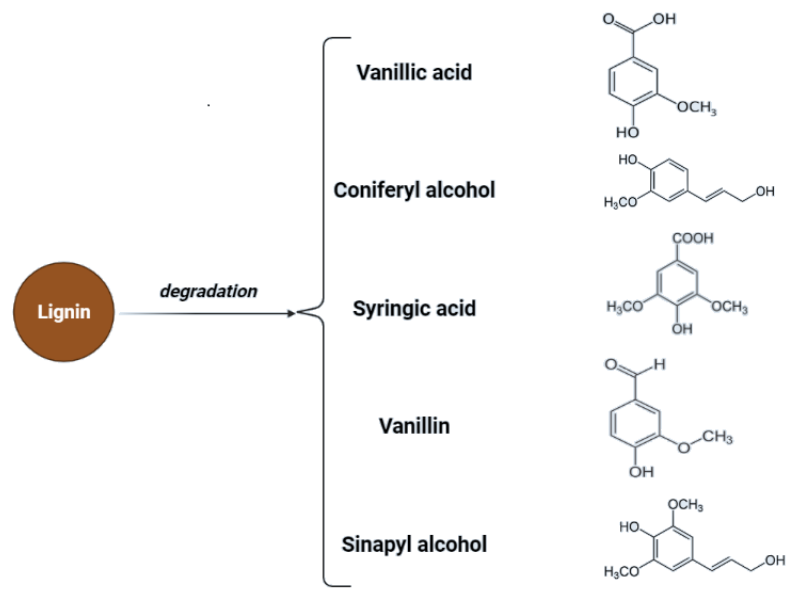
Figure 2. Chemical structures of monomeric compounds in the lignin structure and the main products of lignin degradation.